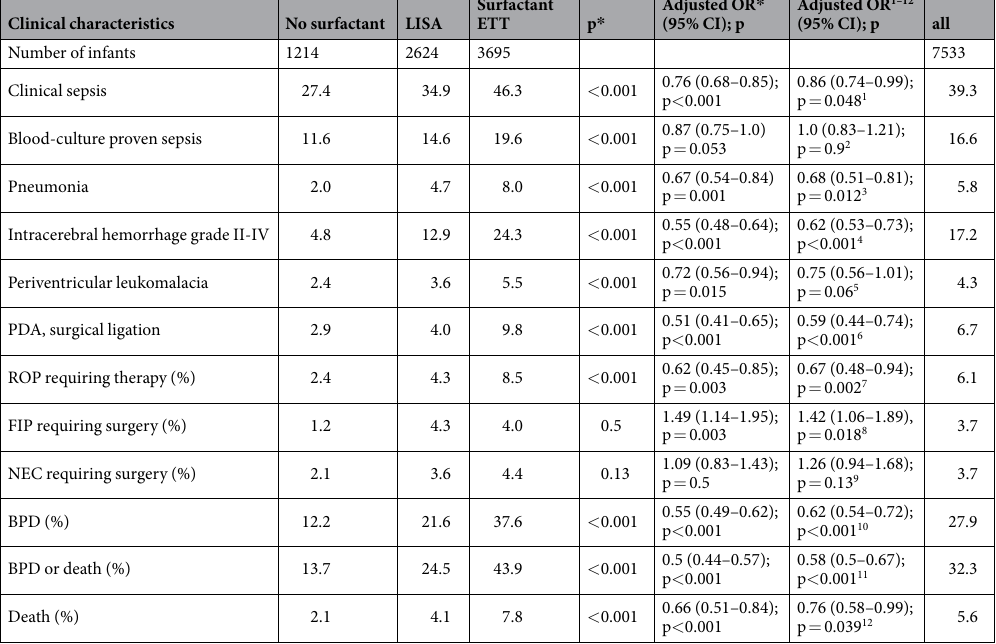
Table 2. Outcomes according to respiratory management/surfactant administration. p-values (LISA vs. Surfactant ETT) are derived from Pearson-chi 2 test; * Adjusted OR indicate the effect of surfactant therapy LISA versus endotracheal tube (ETT) and were derived from multivariable logistic regression models including gestational age (per week), small-for-gestational age (SGA), gender, multiple birth, inborn, antenatal steroids, surfactant LISA or ETT. 1–12 Adjusted ORs indicate the effect of surfactant therapy LISA versus ETT derived from regression models including known risk factors for the respective short term outcomes; specifically: 1, 2, 3 gestational age (per week), SGA, gender, multiple birth, inborn, inotropes first 24 hours, amniotic infection syndrome, anhydramnios > 5 days before birth, antenatal steroids, surfactant LISA or ETT. 4 gestational age (per week), small-for-gestational age, gender, multiple birth, inborn, inotropes first 24 hours, amniotic infection syndrome, antenatal steroids, indomethacin prophylaxis, mode of delivery (spontaneous, elective Caesarean section, emergency Caesarean section), sepsis, surfactant LISA or ETT. 5 gestational age (per week), small-for-gestational age, gender, multiple birth, inborn, inotropes first 24 hours, amniotic infection syndrome, antenatal steroids, surgery NEC or FIP, sepsis, surfactant LISA or ETT. 6,9 gestational age (per week), small-for-gestational age, gender, multiple birth, inborn, inotropes first 24 hours, amniotic infection syndrome, antenatal steroids, surfactant LISA or ETT. 7, 10–12 gestational age (per week), small-for- gestational age, gender, multiple birth, inborn, inotropes first 24 hours, amniotic infection syndrome, antenatal steroids, surgery NEC or FIP, sepsis, surfactant LISA or ETT. 8 gestational age (per week), small-for-gestational age, gender, multiple birth, inborn, inotropes first 24 hours, amniotic infection syndrome, antenatal steroids, postnatal steroids, PDA treatment with indomethacin or ibuprofen, surfactant LISA or